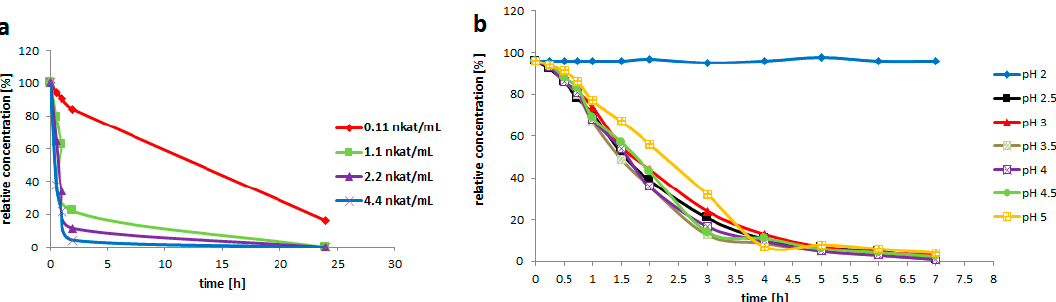
Figure 4. Optimization of reaction conditions for bioconversion of rutin to quercetin. ( a ) Bioconversion of rutin using various amounts of pure rutinosidase (rutin 200 g/L; reaction volume 3 mL; 35 °C, pH 3.0). ( b ) Bioconversion of rutin in 0.2 M glycine buffer at various pH (rutin 200 g/L, reaction volume 3 mL, 35 °C, purified rutinosidase 0.2 U/mL).